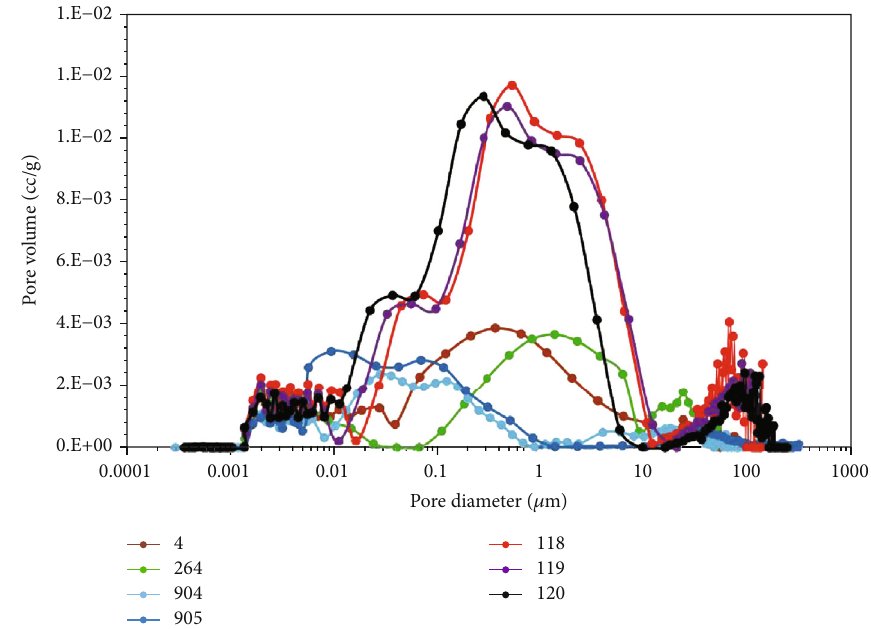
Figure 14: Full PSD curves by integration of N